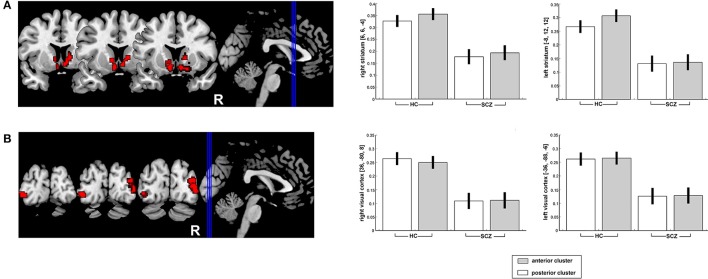
Significantly decreased functional connectivity of the posterior and anterior right DLPFC seeds (conjunction analysis) with the bilateral striatum (A) as well as the bilateral visual cortex (B) in SCZ patients as compared to HC. Results are projected onto the MNI single-subject template on the left side and contrast estimates for the effect in the point maximum respective region are shown on the right.